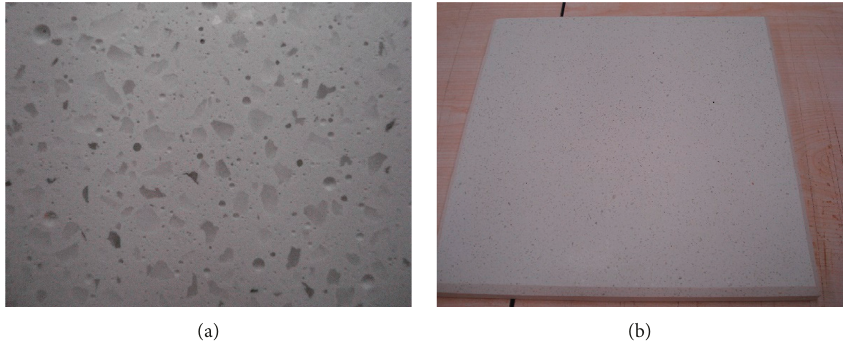
Figure 2: (a, b) Sand blasting applied